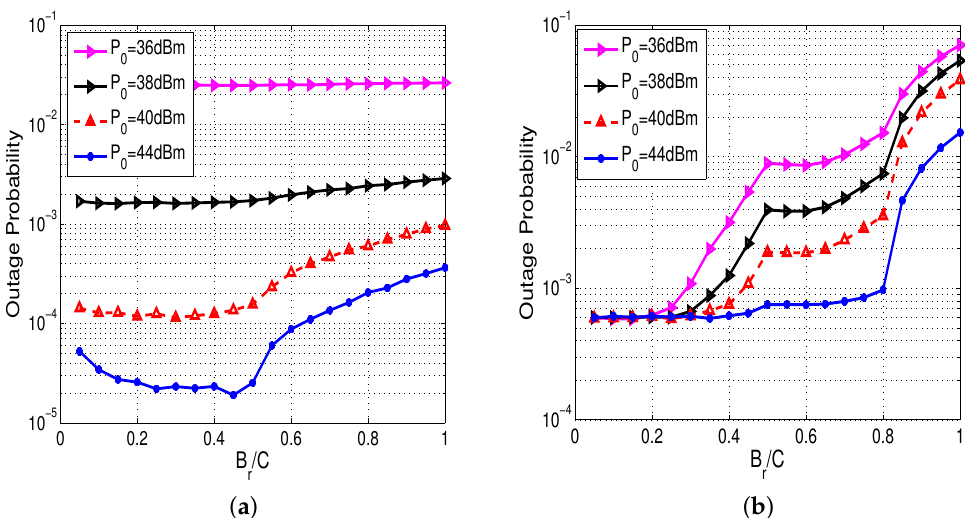
Figure 6. Outage probability of the sensor in the far and near cluster versus the relaying energy threshold B r . ( a ) far cluster; ( b ) near cluster.